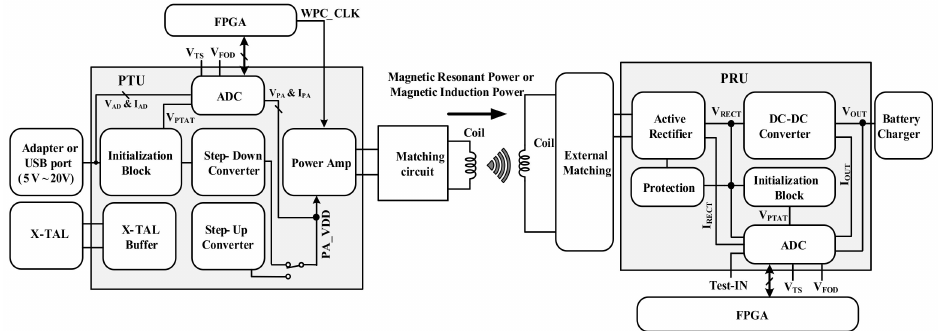
Figure 1. Wireless power transfer system including PTU and PRU. FGPA: field-programmable gate array; PTU: power transmitter unit; PRU: power receiver unit; ADC: Analog-to-digital